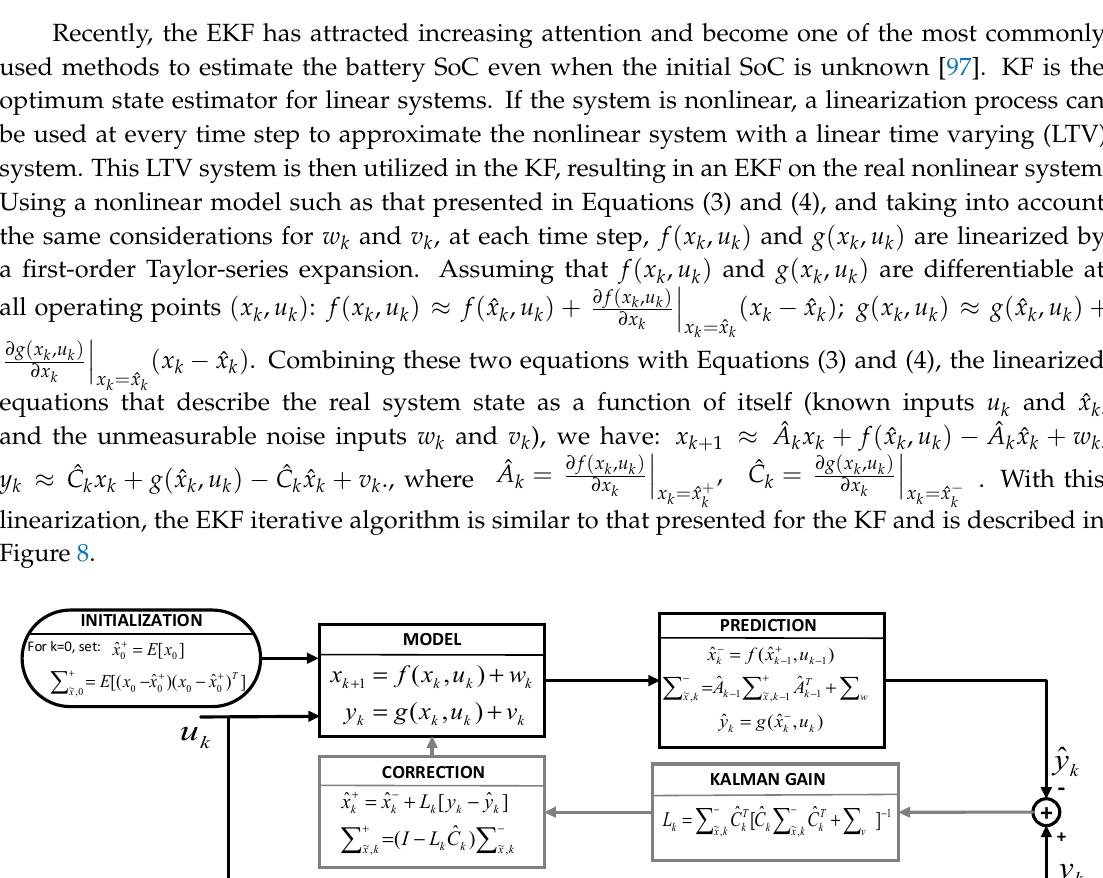
k y k y ˆ Figure 9. Unscented Kalman filter iteration diagram.